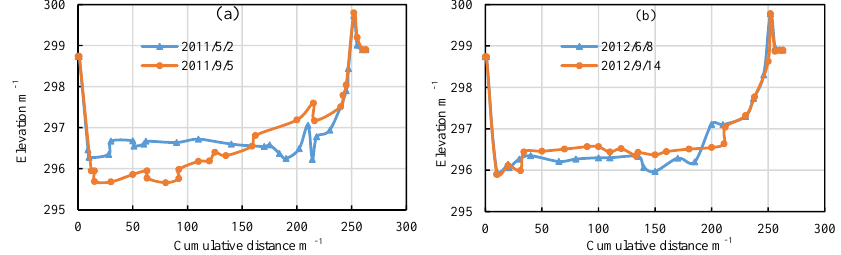
Figure 2. Comparison of large cross-section measured before and after flood season at the Taihekou (Xi) station ( a : 2011, b : 2012).